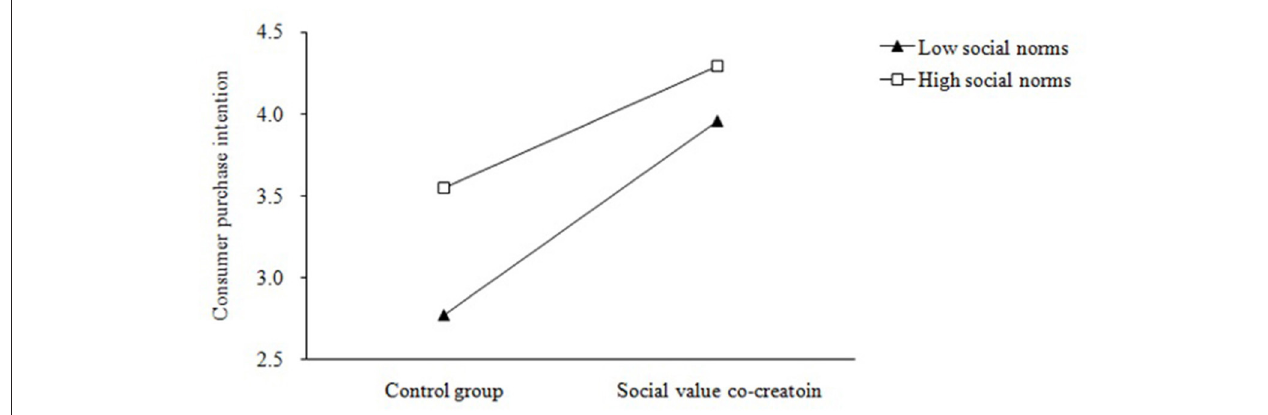
FIGURE 2 | The interaction effect of social value co-creation on purchase